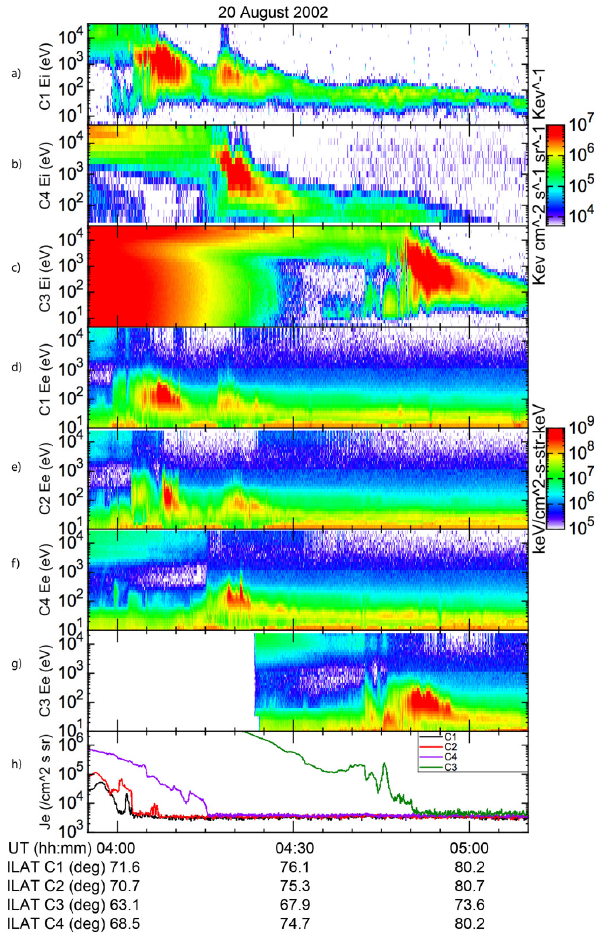
Fig. 3. Omnidirectional ion (CIS) and electron (PEACE) spectro- grams on (a) , (d) C1; (e) C2; (b) , (d) C4; and (c) , (g) C3 on 20 Au- gust 2002. The last panel (h) shows the integrated flux of electrons (RAPID) between 50 and 400keV from the four